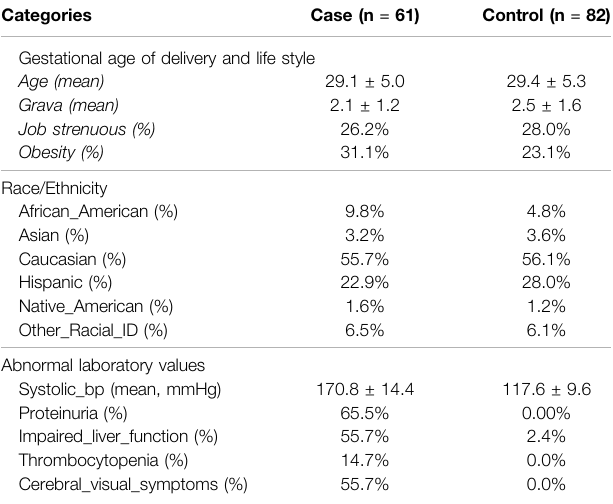
TABLE 1 | Clinical characteristics of patients. Mean